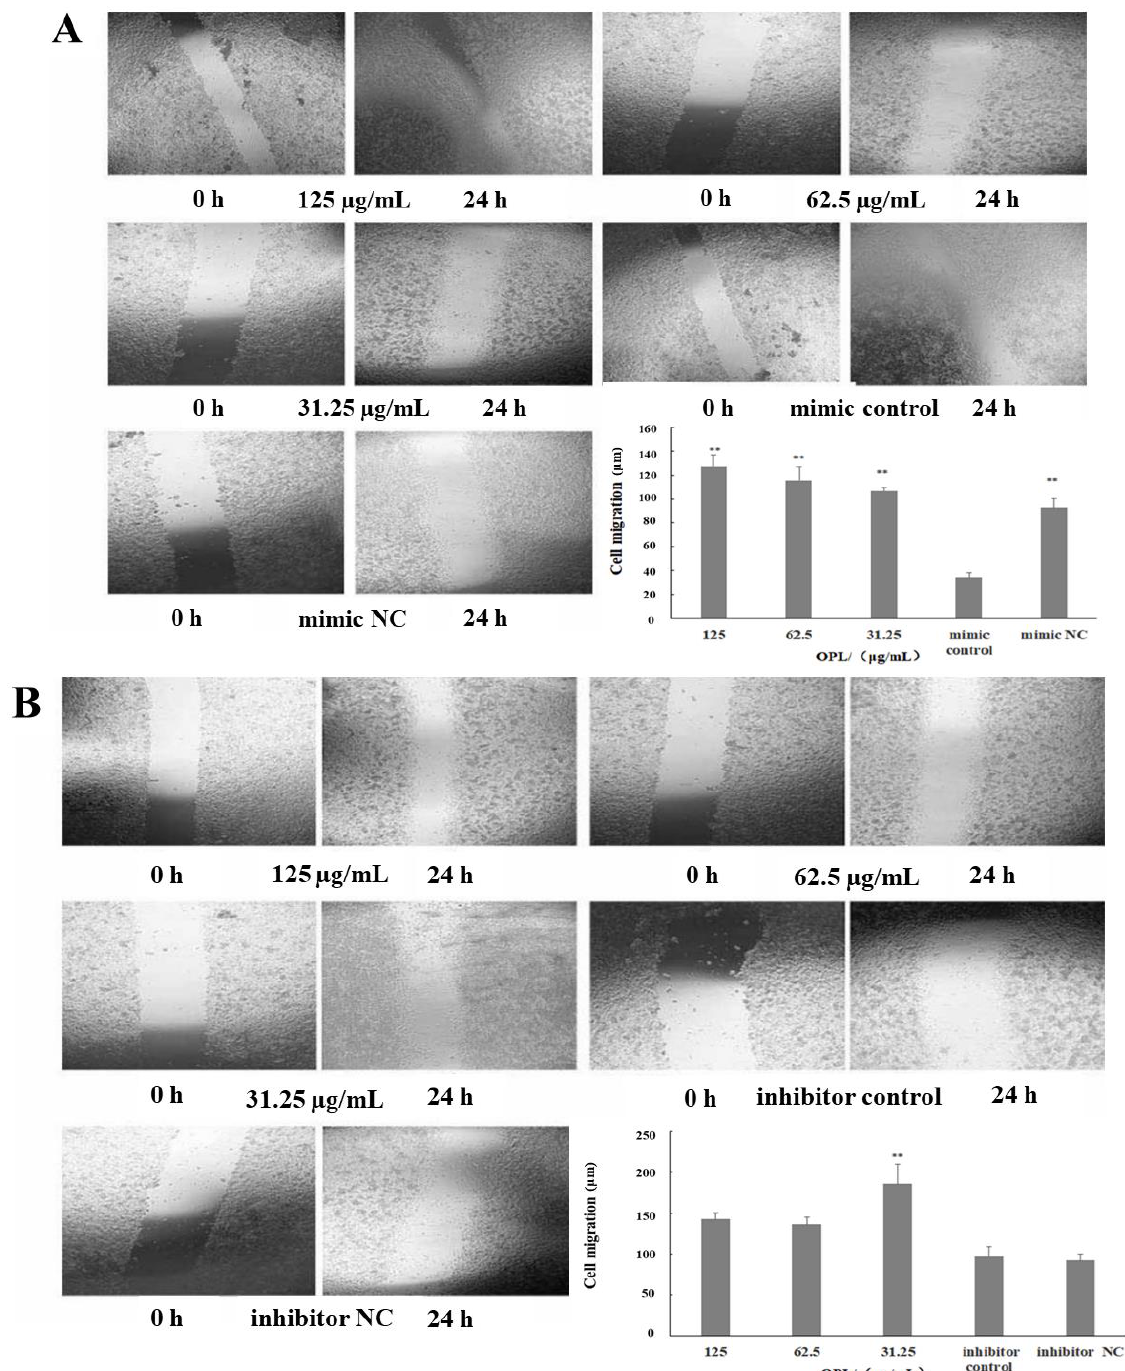
Figure 3. The effect of OPL on cell migration. ( A ): Cell migration in the transfected miR-4796 mimic group (×40); ( B ): cell migration in the miR-4796 inhibitor transfected group (×40). Each value represents the mean ± SD ( n = 3). ** p < 0.01 compared with control group.